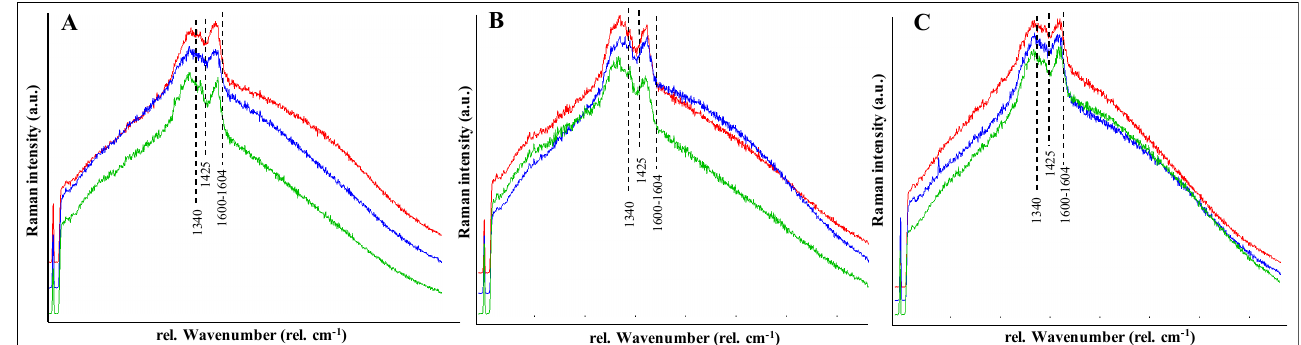
7 of 16 Figure 1. UV–VIS-spectra of melanin pigment extracted from C. antarcticus colonies grown on ( A ) OS exposed to simulated space conditions; ( B ) P-MRS and ( C ) S-MRS exposed to Mars-like conditions on different layers: Top (exposed to sun light with 0.1% Neutral Density filters) = red spectrum, Bottom (dark control in space, not exposed to space radiation) = blue spectrum and CTR (sample kept in the lab, in the dark at room temperature) = black spectrum. OS = Original Substrate, P- MRS = Phyllosilicatic Mars Regolith Simulant, S-MRS = Sulfatic Mars Regolith Simulant. 3.2. Detection of Pigments by Confocal Raman Spectroscopy Colonies of C. antarcticus grown on different analogues were analyzed by Confocal Raman spectroscopy after exposure to simulated space and Mars-like conditions. The results of Raman analyses identified the melanin spectra with two main peaks, according to [37]: an intense and broad peak at 1590–1605 cm − 1 and a second peak at lower